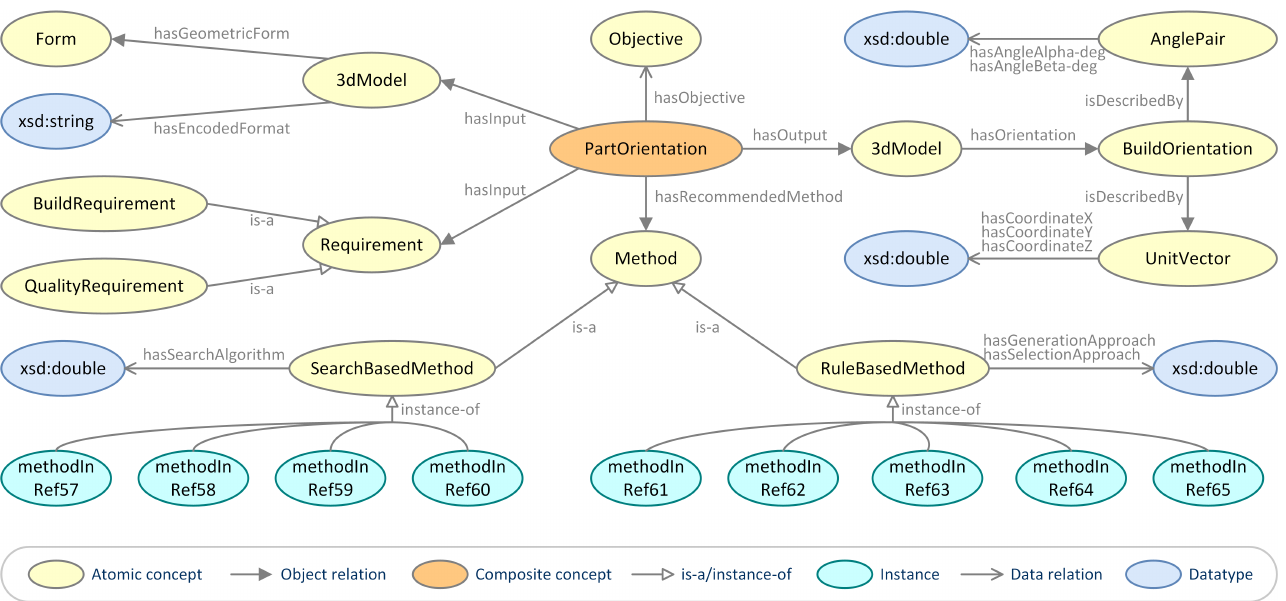
Figure 4. An ontological view of part orientation for